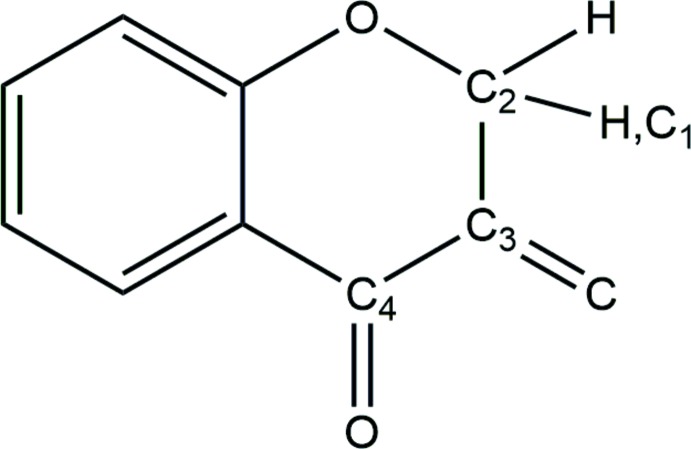
Reference moiety for database survey.